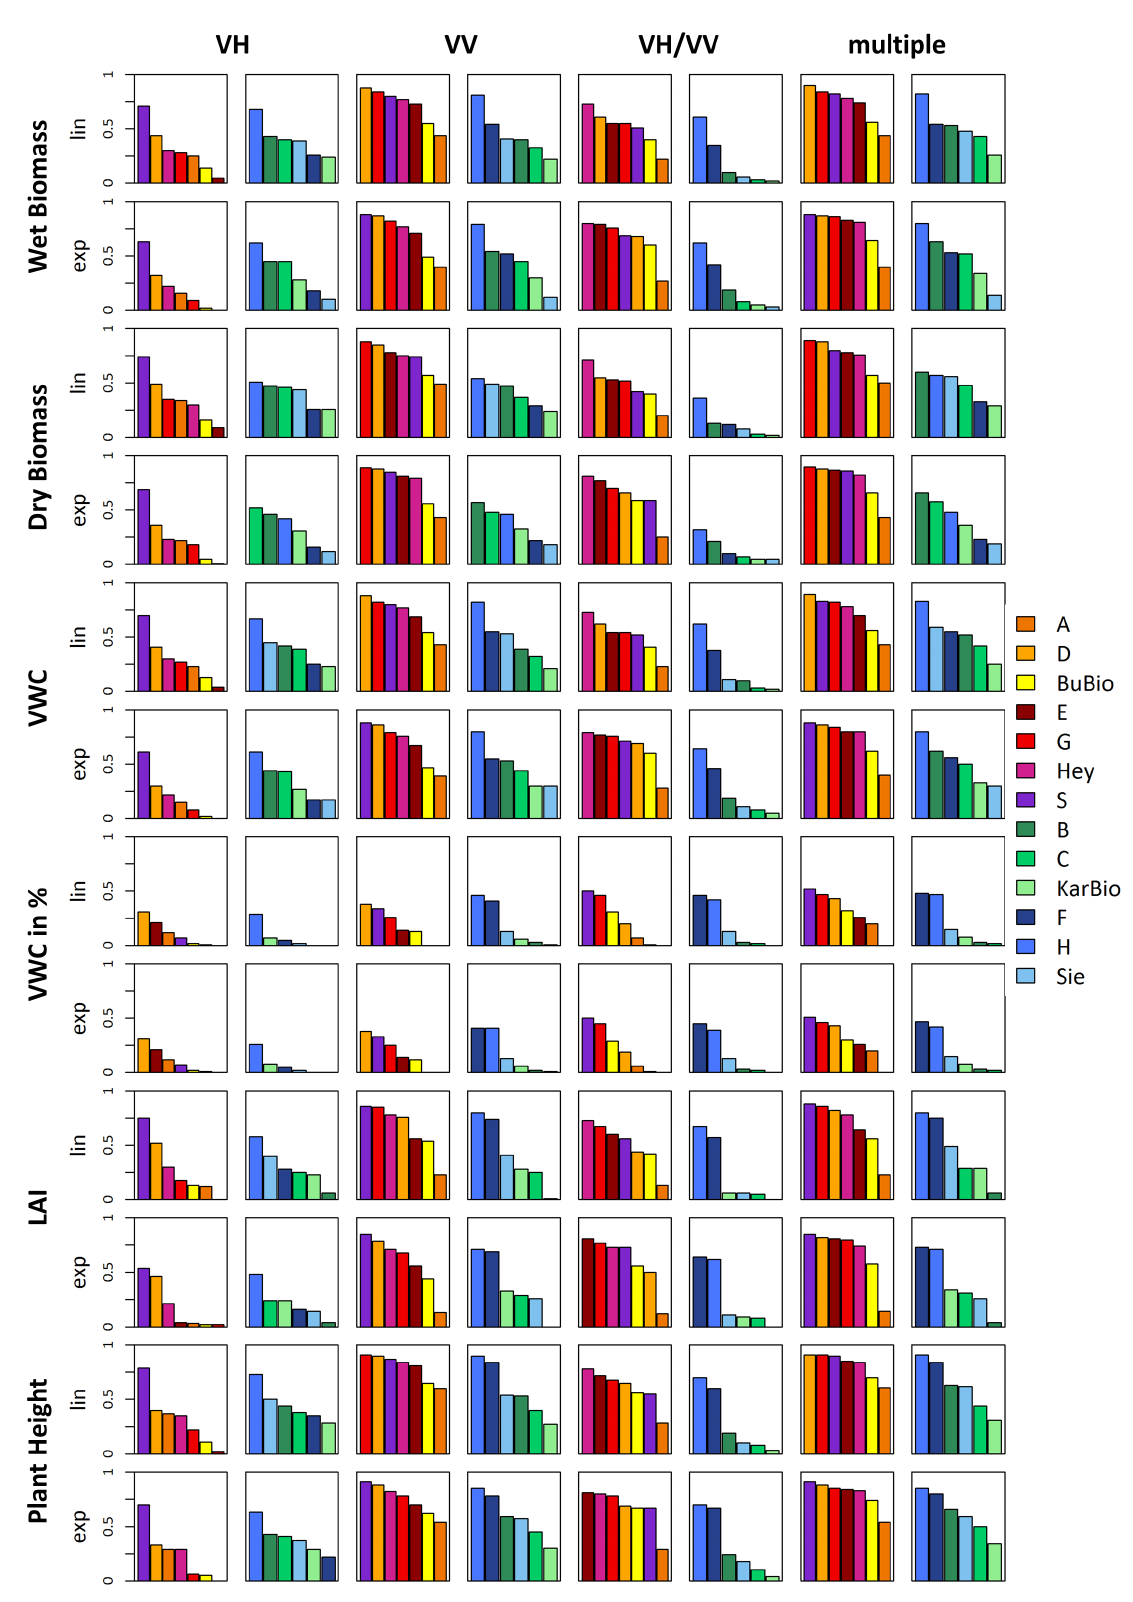
Figure 17. Bar plots of R 2 values of regression between crop and backscatter parameters per crop type for single fields in BBCH stages